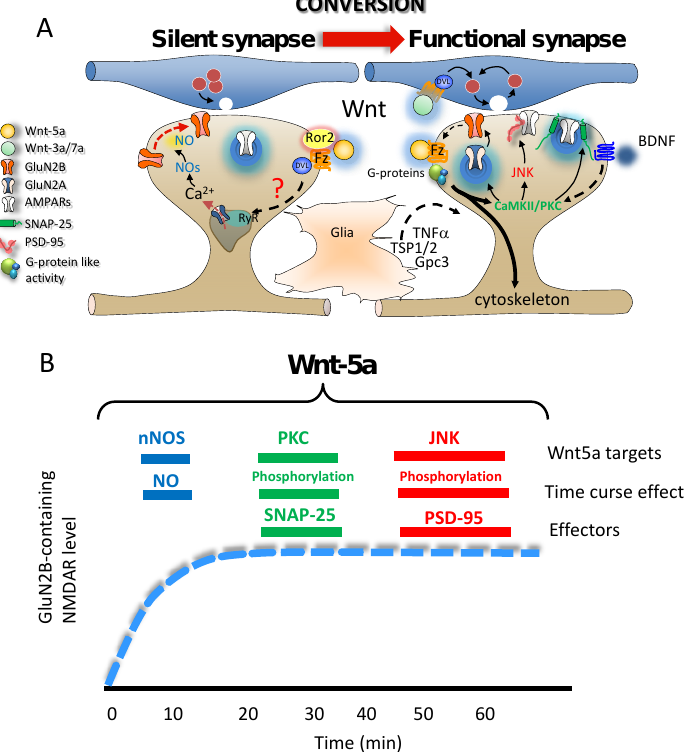
Figure 3. Time course of Wnt signaling activation over GluN2B-containing NMDARs. ( A ) At the post-synaptic level, the formation of silent synapses requires binding of the Wnt5a ligand to Frizzled (Fz) or Ror2 receptors; this binding activates downstream targets, such as nNOS, PKC, CaMKII, and JNK, which can modulate GluN2B-containing NMDAR translocation in synapses. The transformation of silent into functional synapse by Wnt5a ligand-mediated activation of the CaMKII/JNK and PKC/SAP-25 cascades promote the replacement of GluN2B/GluN2A-containing NMDARs and AMPAR insertion. At the presynaptic level, Wnt3a/7a ligands promote the maturation of the neurotransmitter release machinery. The G protein-like activity associated with the Fzd receptor has been identified as a modulator of cytoskeleton. Activation of this cellular pathway, in conjunction with external neuroactive factors, including BDNF, Gpc3, TNF- α , and TSP1/2, controls the conversion of silent synapses to functional synapses?: indicates the process under study. ( B ) Throughout the time course of the effects of the Wnt5a ligand on GluN2B-containing NMDARs, the activation of primary targets, including nNOS, PKC, and JNK, which are activated at different times, results in downstream activation of several effectors. NO production occurs over the shortest time period (within 5 min) and is followed by SNAP-25 phosphorylation (at approximately 20 min) and PSD-95 phosphorylation (after 1 h of Wnt ligand